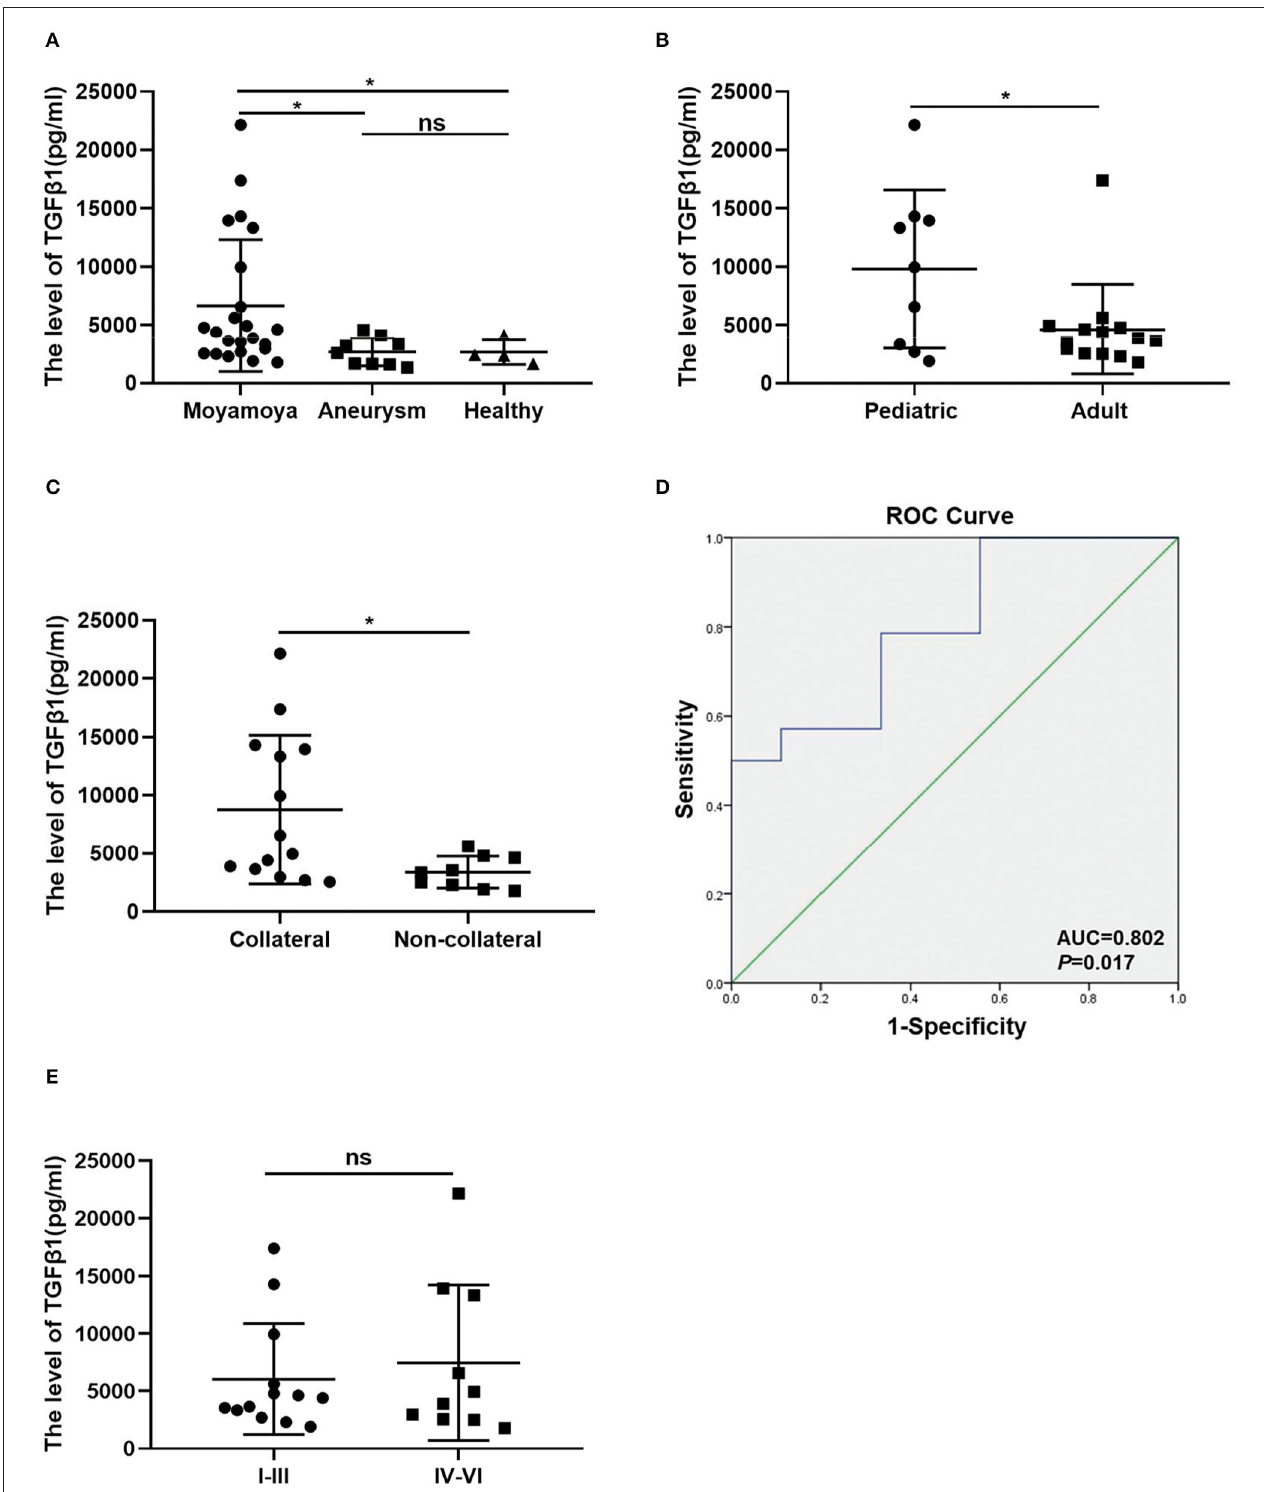
FIGURE 3 | TGF β 1 is associated with transdural collaterals in MMD. (A) The levels of TGF β 1 were significantly increased in MMD patients compared to other groups. (B) the Expression level of the TGF β 1 in plasma between pediatric group ( n = 9) and adult group ( n = 14). (C) The different concentration of TGF β 1 between collateral group ( n = 9) and non-collateral group ( n = 14). (D) The value of the TGF β 1 predicted the collateral formation being analyzed by ROC curves. (E) The level of TGF β 1 between Suzuki I-III ( n = 13) and IV-VI ( n = 10). ns, non significant ( p > 0.05), * p < 0.05.